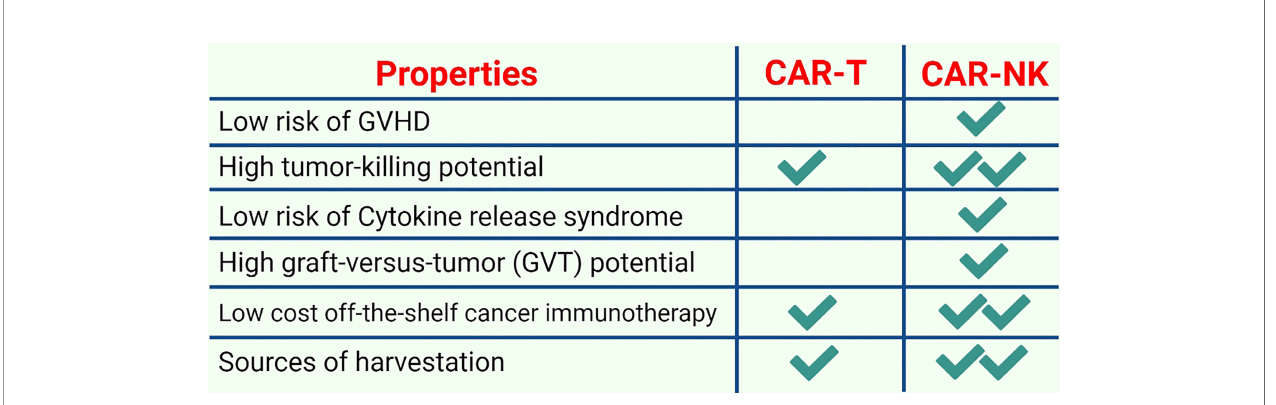
FIGURE 6 | A comparison of CAR-T and CAR-NK immunotherapy: CAR-NK cell therapies are becoming increasingly popular due to several advantageous features such as low safety concerns, low costs, and higher tumor